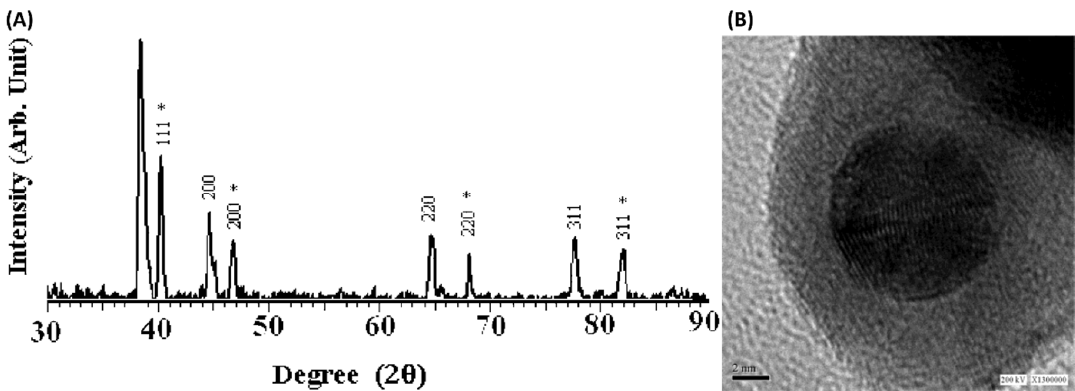
Figure 5. ( A ) XRD (the asterisk indicates Pd) and ( B ) HRTEM image analysis of Au core-Pd shell NPs. Adapted with permission from the American Chemical Society. Copyright 2004 American Chemical Society.